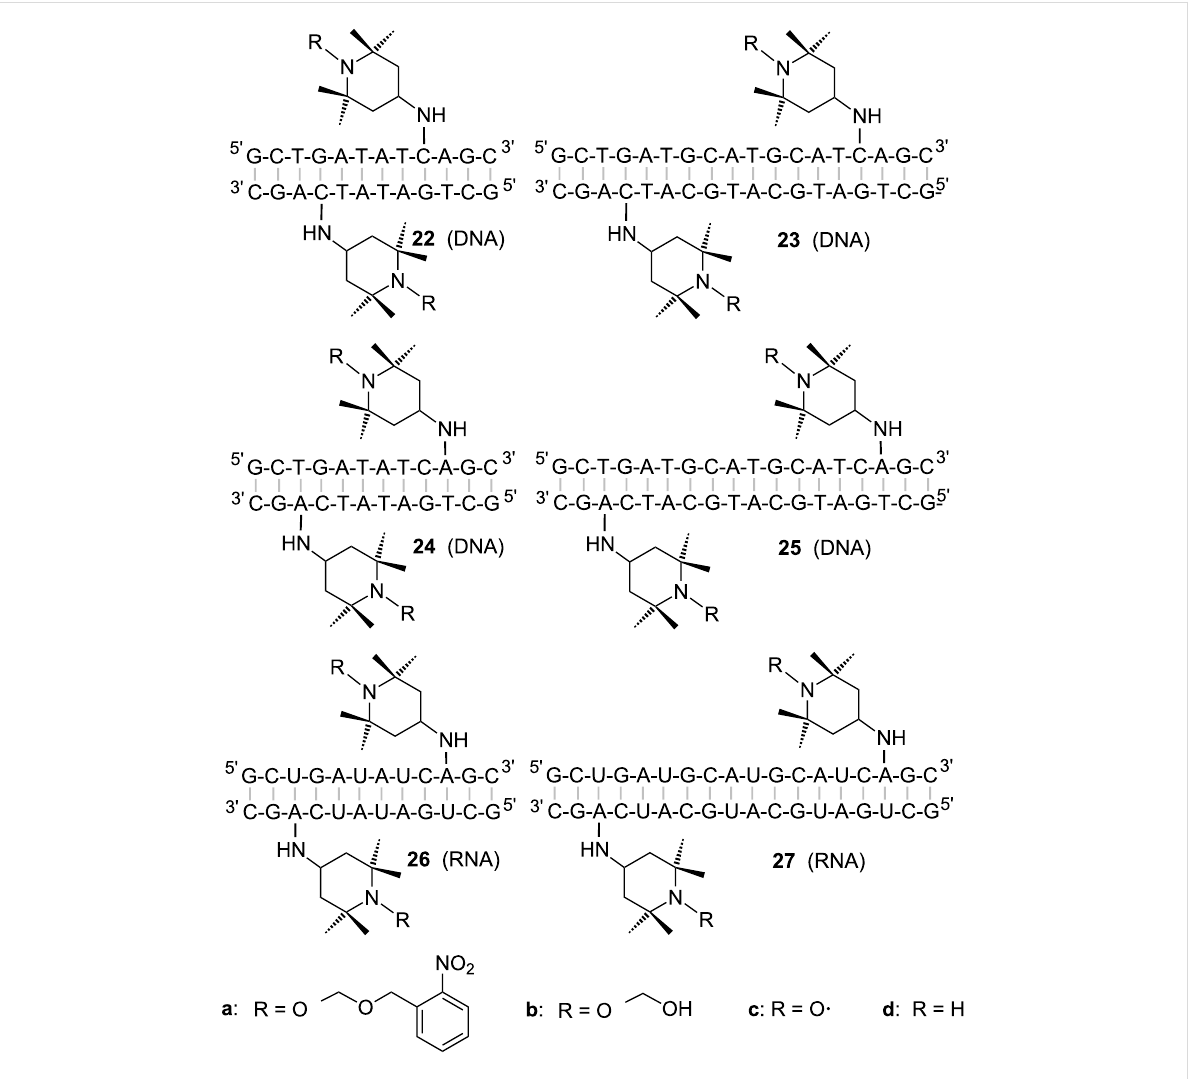
Figure 2: Structures of palindromic oligonucleotides prepared from amidites 5 ( 22a , 23a ), 7 ( 24a , 25a ), and 8 ( 26a , 27a ). Hemiacetals 22b – 27b were obtained after photochemical deprotection (custom built apparatus with three LEDs Nichia NCCU033, 365 nm, each with 100 mW optical output power [41]. 20 min irradiation in 10 mM phosphate buffer, pH 7.4). Subsequent elimination of formic aldehyde and air oxidation transformed these intermediates into nitroxides 22c – 27c . Amines 22d – 27d , typical degradation products of nitroxides, could not be